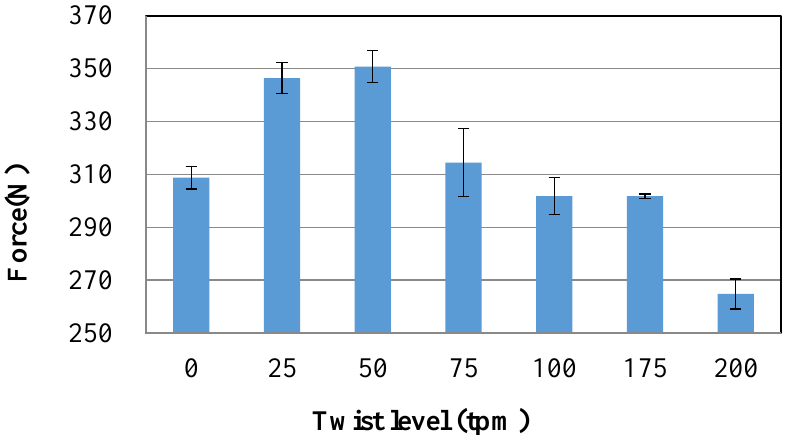
ff erent twists HMWPE